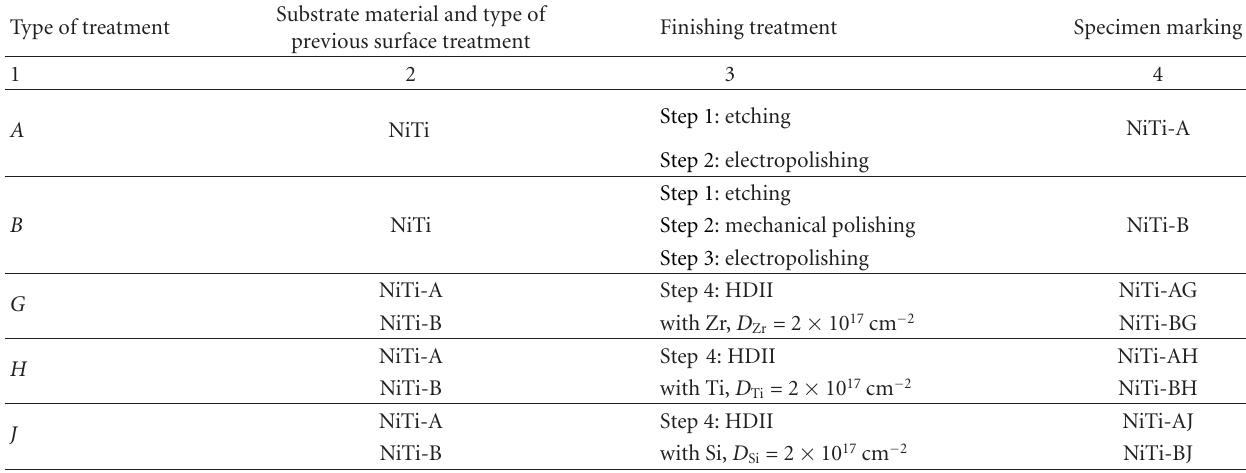
Table 1: Types and description of surface treatment of the NiTi specimens.